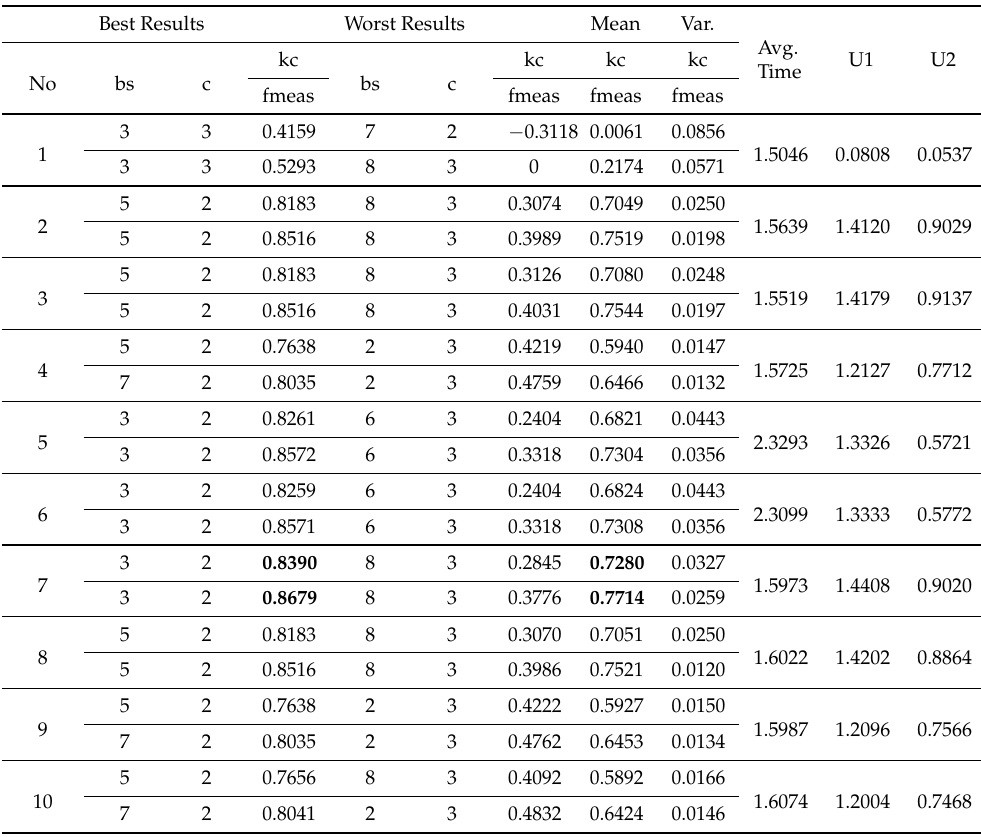
Table A2. Results of Yellow River Estuary